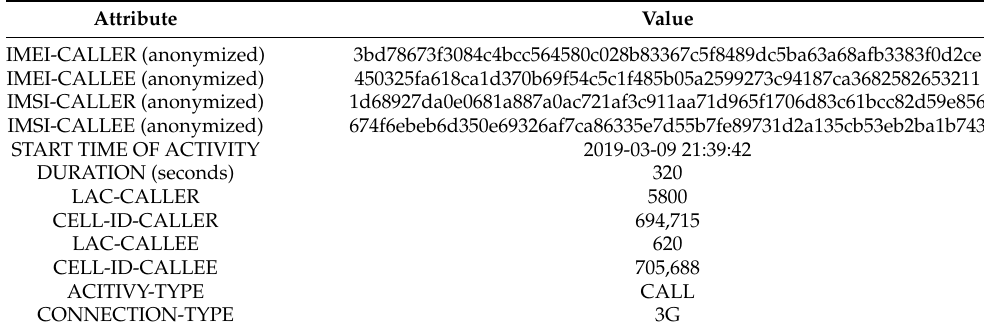
Table 1. Example of an anonymized mobile CDR.